Question: Condense the content of this figure into a single sentence.
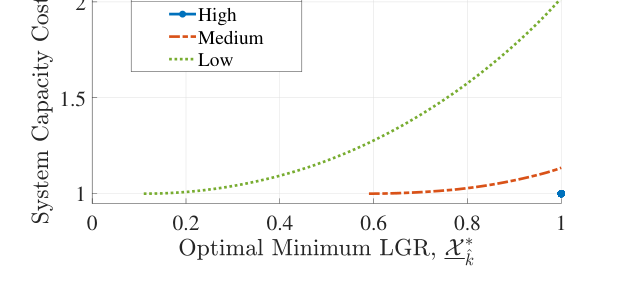
Answer: Pareto-optimal front of (P4) for different energyshed boundaries. Capacity costs are normalized with respect to the baseline case (X k =0).